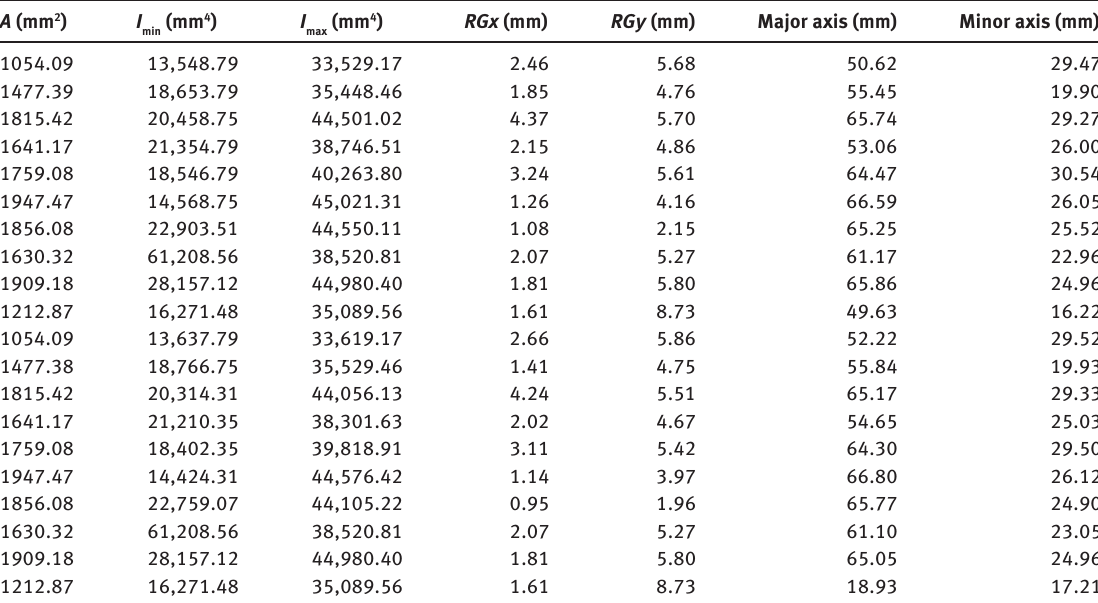
Table 1: A Sample Database (Right Ear).